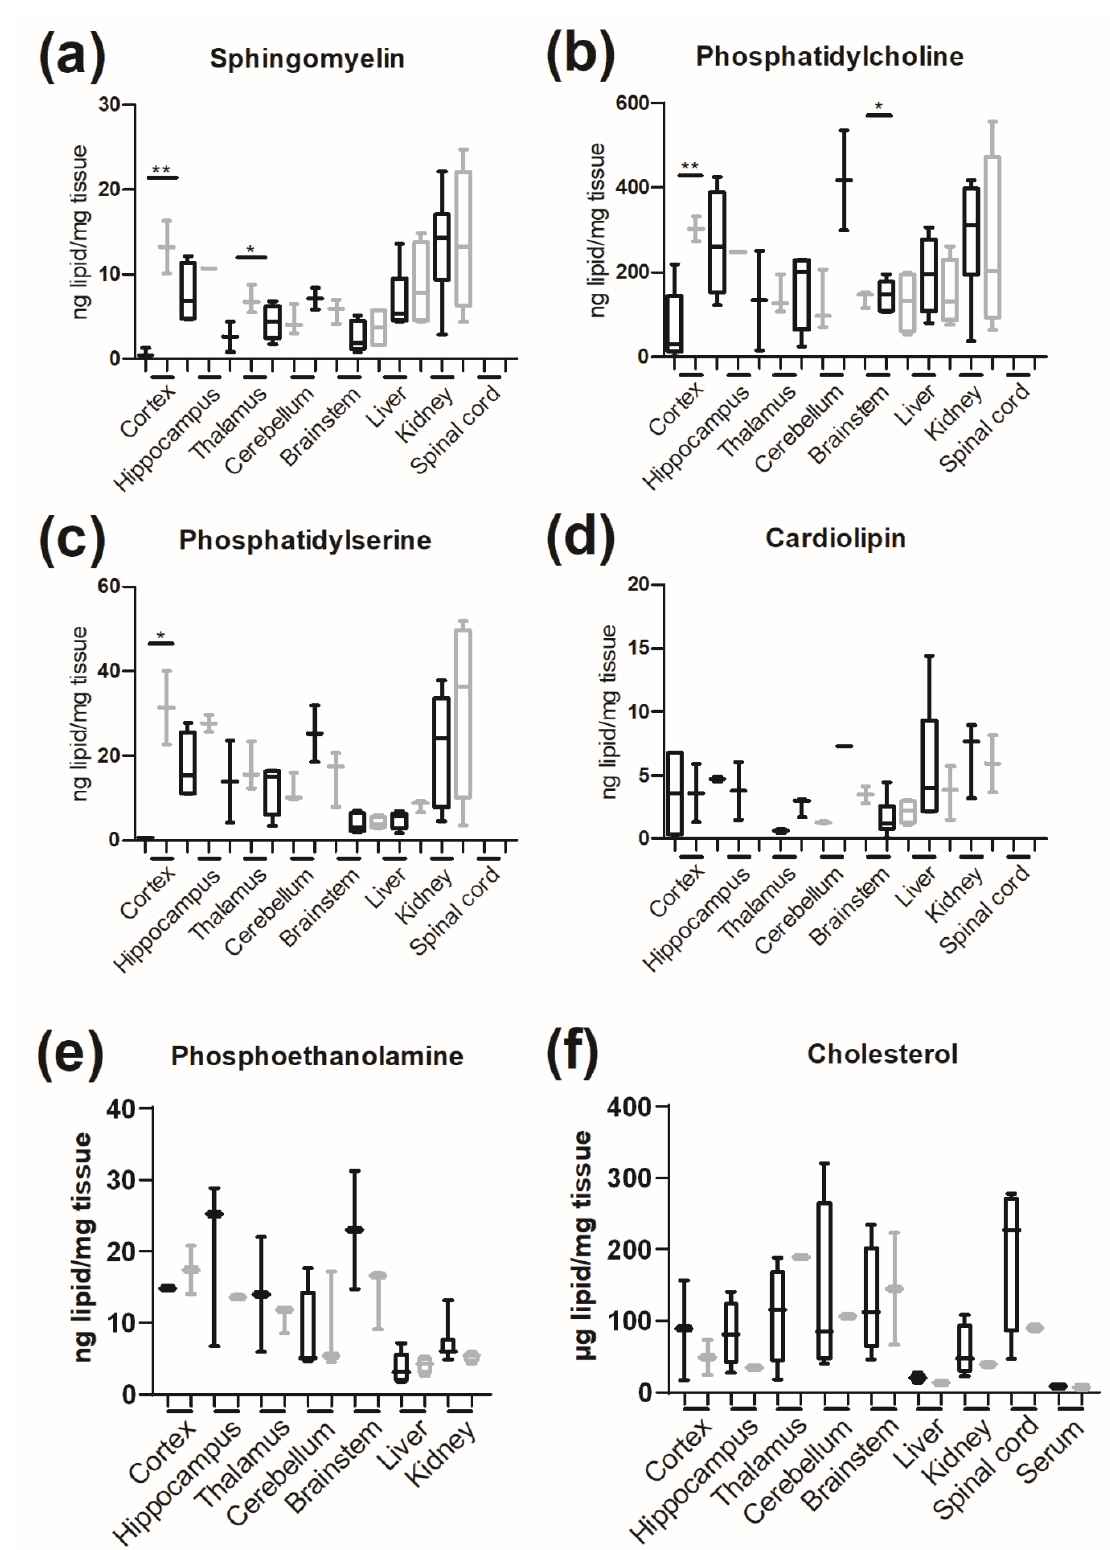
Figure 9. Lipid content of tissues. ( a – e ) TLC analysis of four-month-old Glb1 − / − and wildtype (WT) fibroblasts; ( f ) HPLC analysis for cholesterol. * p < 0.05; ** p < 0.01. Box plots are used to show data; n = 4.